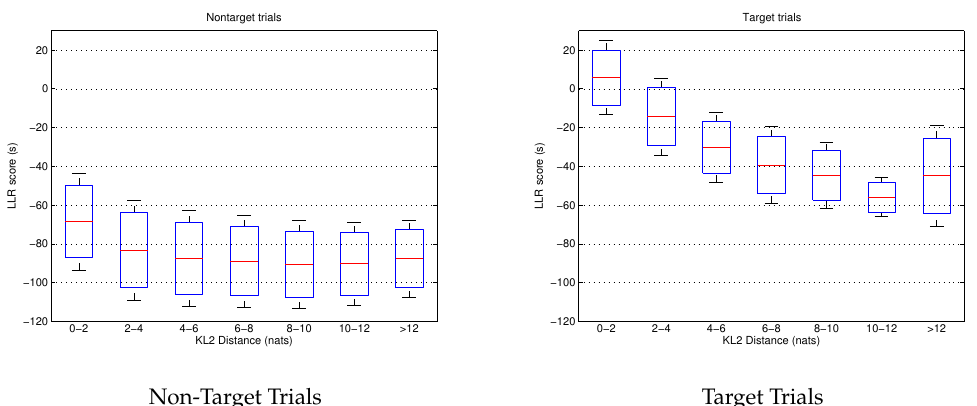
Figure 6. Trial score in terms of KL2 distance for the whole data pool. Represented the mean and the mean plus/minus the standard deviation.